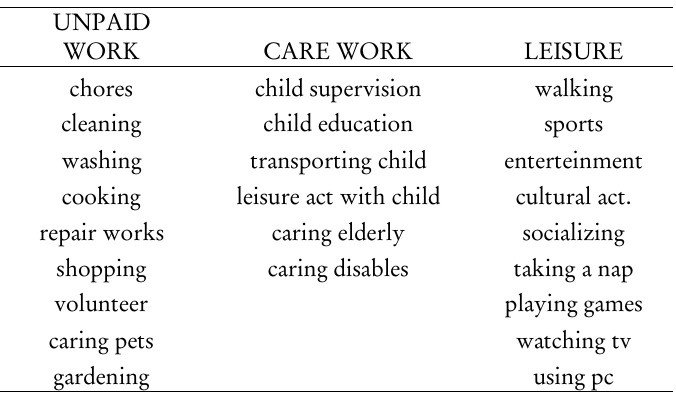
Time Use Survey activities definition and